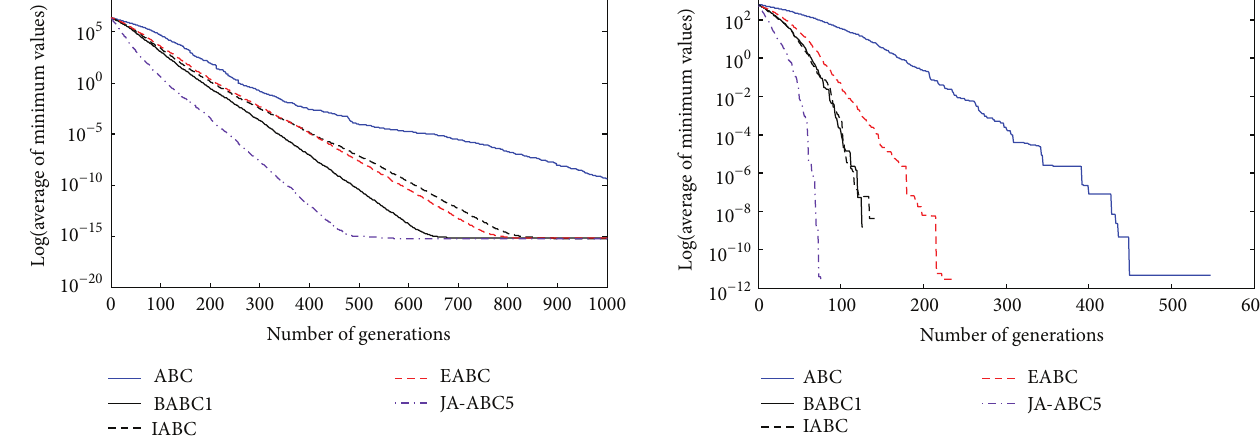
Figure 6: The convergence rates of the optimization algorithms on Rotated Griewank function.